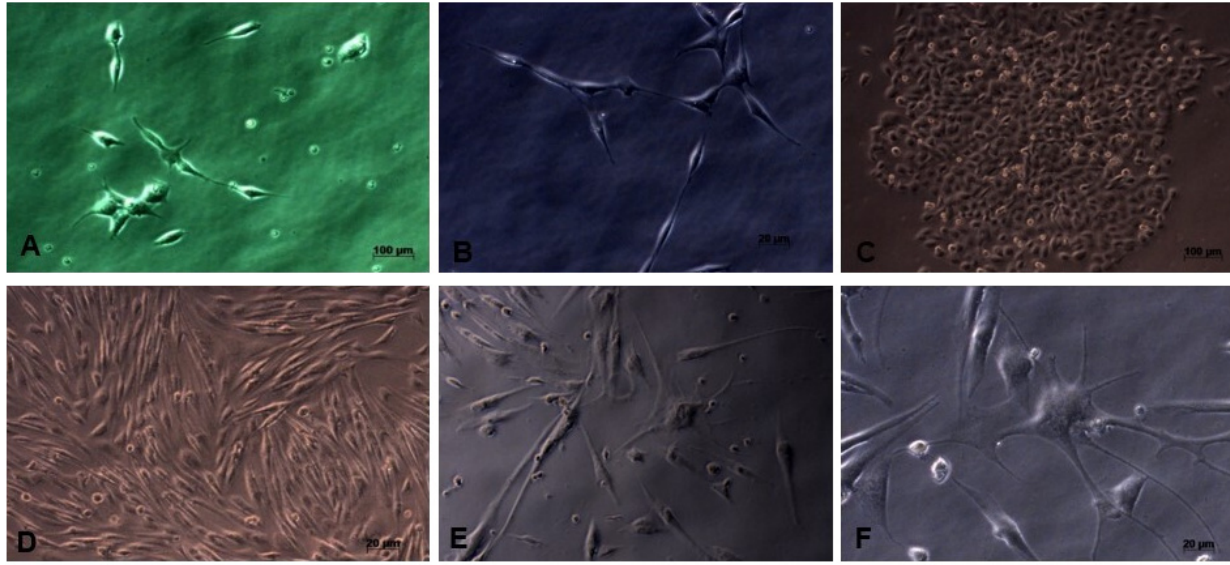
Figure 1. The appearance of the cultured neuron cell line SHSY-5Y; it appears that the SHSY-5Y cells have a neuronal-like cell shape. ( A ) Cell image of 3 days culture (40x enlargement). ( B ) Cell image after 7 days, showing elongation of neuron cell bodies and cells growing in groups (40x magnification). ( C ) There is an increase in cell proliferation and group cell growth (20x magnification). ( D ) The cells have reached 80% confluence and are ready to be harvested (20x magnification), ( E and F ) SHSY-5Y cells have undergone differentiation, seen the presence of axons from cells and the cell proliferation process begins to decline (40x magnification). Underlying data shows raw, unprocessed images used to generate this figure 13